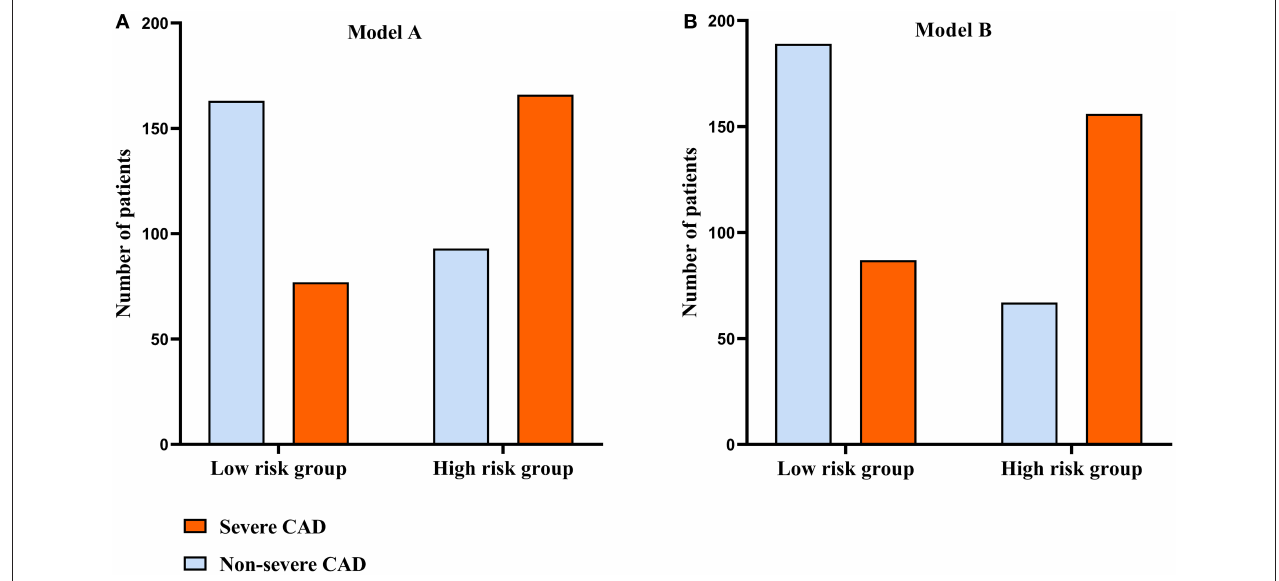
FIGURE 5 | Comparison of the distribution of patients between the groups classified according to the optimal cut-off value of the model A and model B. (A) The distribution of patients classified by model A. (B) The distribution of patients classified by model